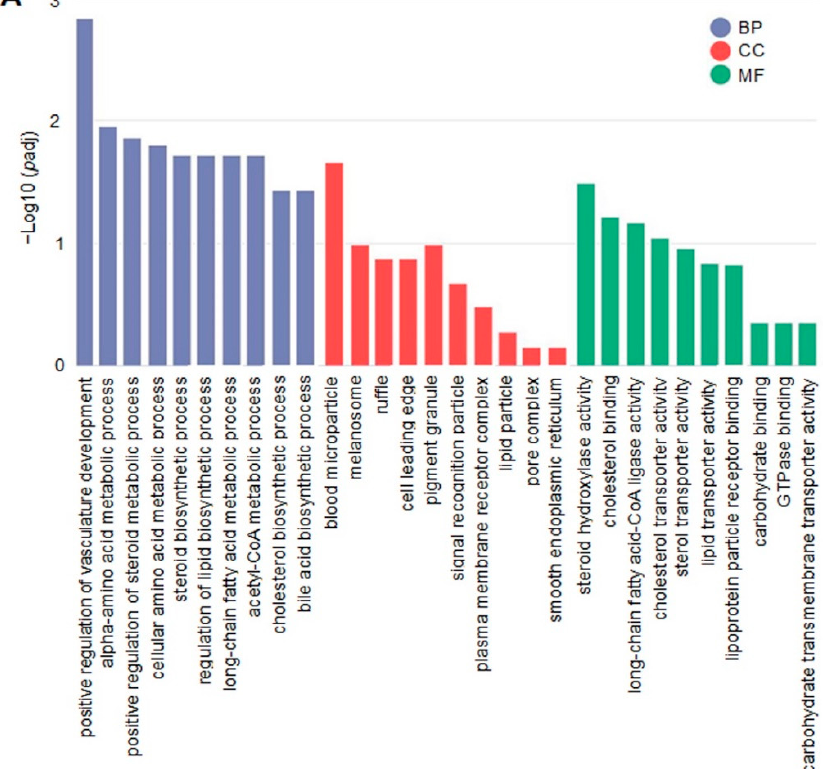
Figure 4. GO and KEGG pathway enrichment analysis of DEGs. ( A ) GO annotation and classifica- tion based on biological process (BP), cellular component (CC), and molecular function (MF). ( B ) KEGG enrichment bubble chart. The color of the point indicates the q-value of the hypergeometric test, and the size represents their corresponding number of genes in their pathway.